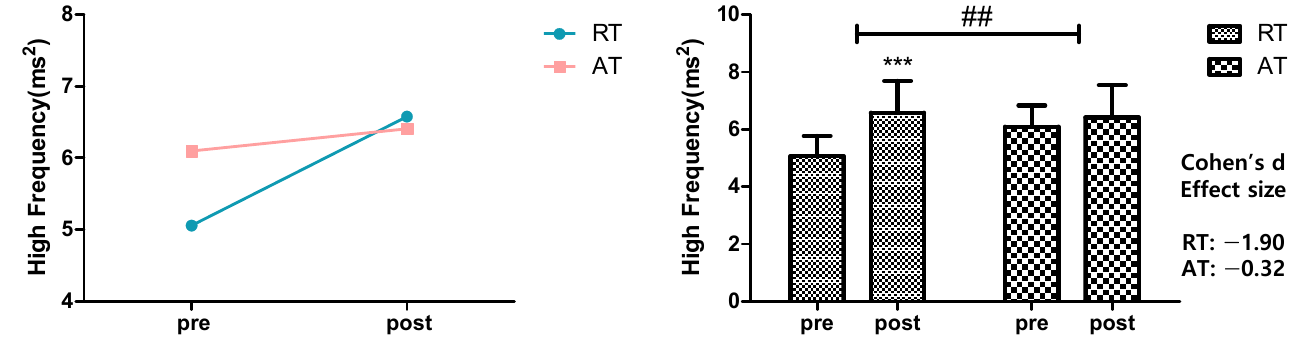
Figure 3. Effects of 12-week resistance training and aerobic training on Low Frequency. HF has significantly increased in the RT (*** p < 0.001) compared to the pre-test. HF showed a significant interaction effect (## p < 0.01). The data presented were mean ± SD. *** p < 0.001; before and after significant. ## p < 0.01; interaction significant. Effect size range: |0.20| ≤ small < |0.50| < medium < |0.80| ≤ large. RT = resistance training, AT = aerobic training, HF = high frequency.